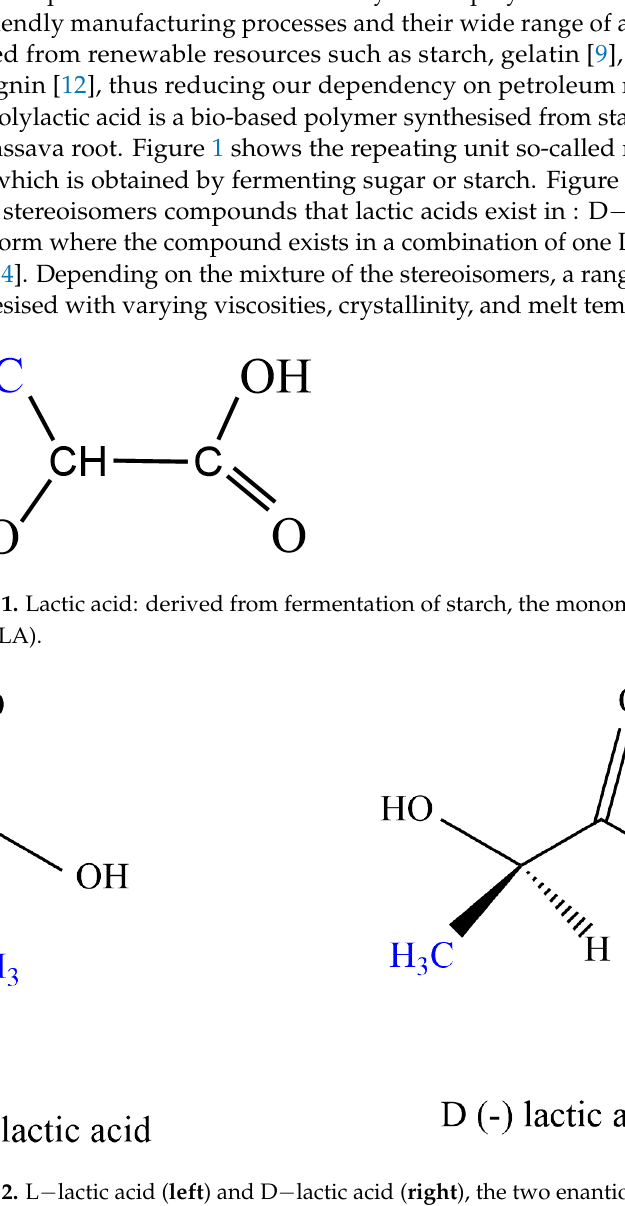
Figure 2. L − lactic acid ( left ) and D − lactic acid ( right ), the two enantiomeric forms of the monomer lactic